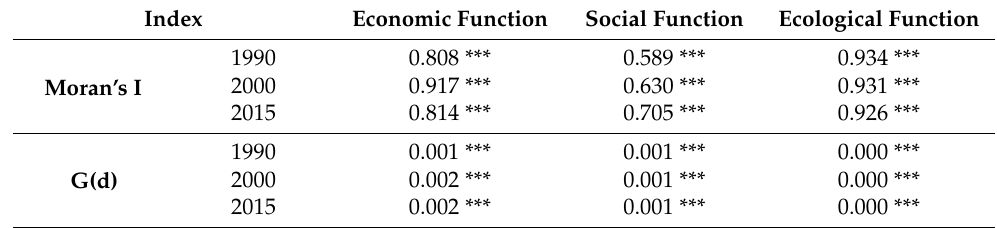
Table 3. Moran’s I and G(d) of LUFs in the whole case study area of Zhangjiakou City (1990–2015).